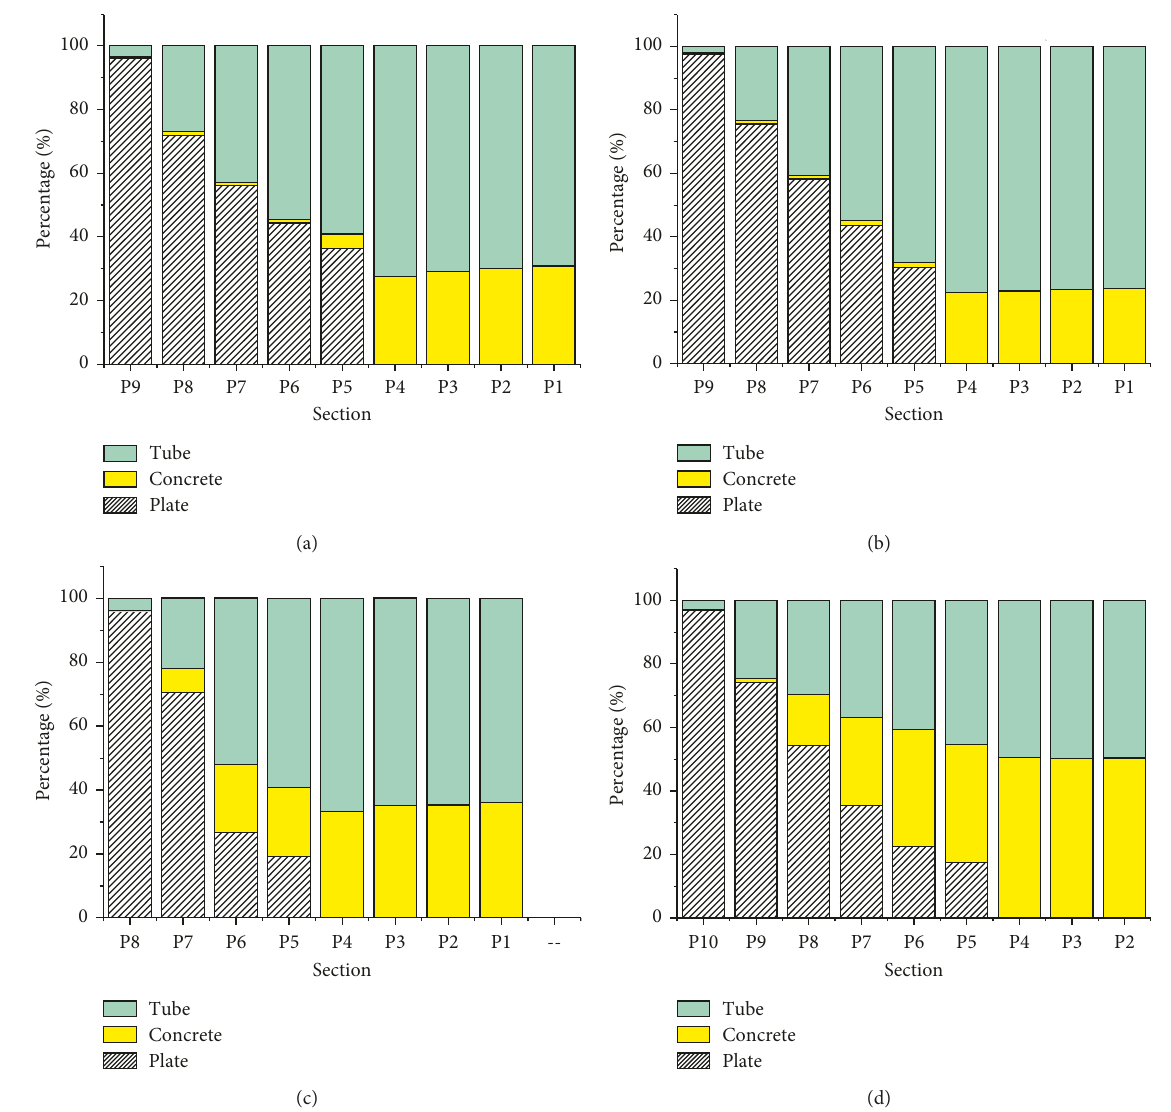
Figure 15: Axial force at different sections: (a) SJ1-1; (b) SJ1-2; (c) SJ1-3; (d)